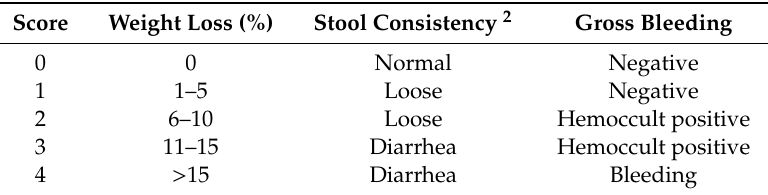
Table 1. Scoring system for DAI 1